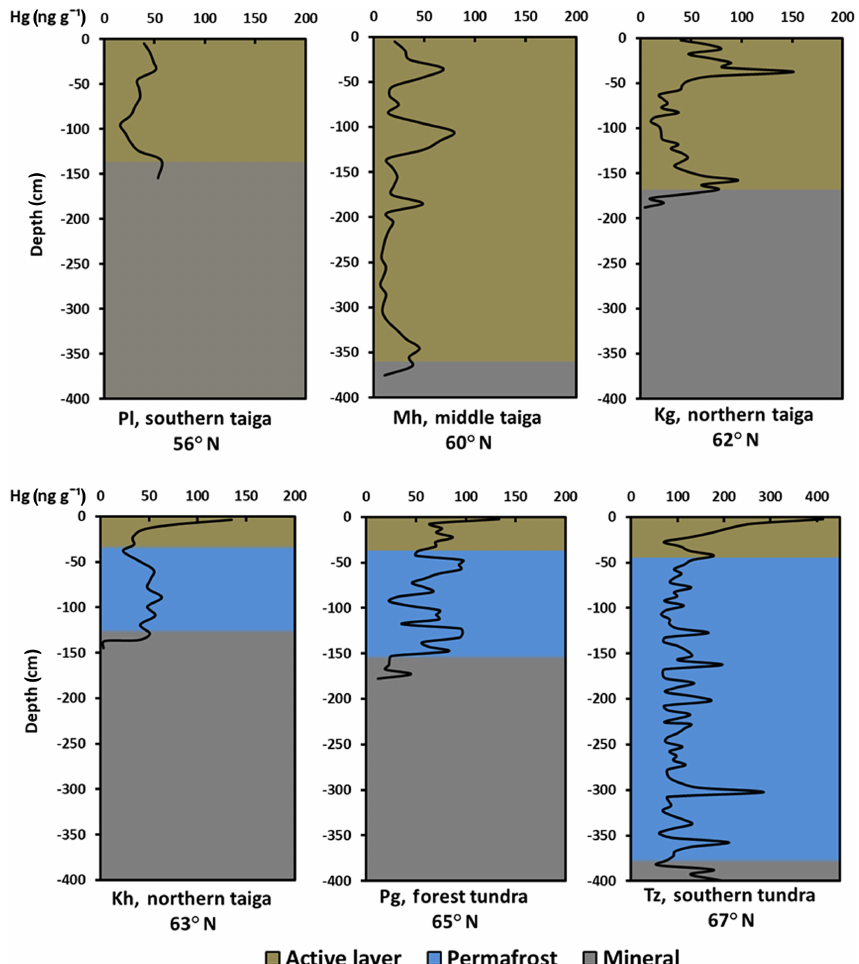
Figure 2. Vertical-depth profile distribution of total Hg (THg) in six peat cores across a 1700km latitudinal transect of the WSL. Site location and physiogeographical parameters are shown in Fig. 1 and Table